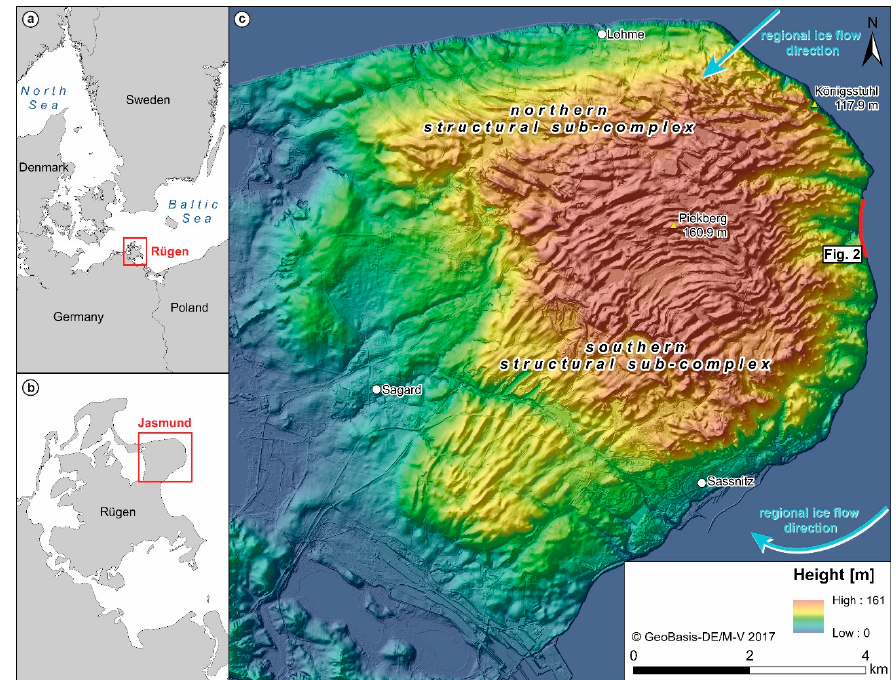
Figure 1. Overview maps of Rügen Island in the southwestern part of the Baltic Sea ( a ) and the Jasmund Peninsula in the northeast of Rügen ( b ); The digital elevation model with a solution of 5 m (DEM5, 10 times exaggerated, hillshade) of the Jasmund Peninsula shows the topography and the separation of the surface into a northern and southern ridge domain representing structural sub-complexes of the entire glacitectonic complex ( c ). The regional Weichselian ice flow directions from NE and SE are shown as light blue arrows.